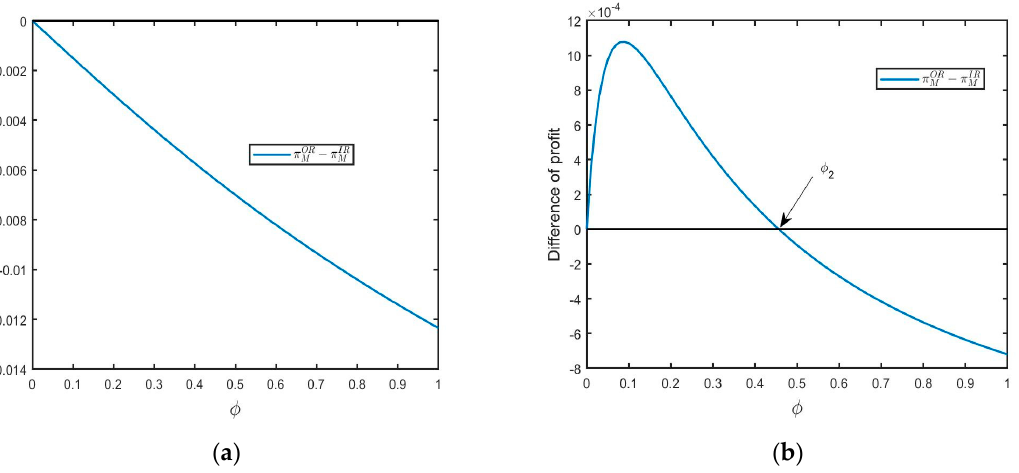
Figure 4. The impact of φ on profit difference: ( a ) µ 2 < σ 2 ( µ = 0.1, σ = 0.2, δ = 0.5 ) and ( b ) µ 2 > σ 2 and δ > δ 1 ( µ = 0.5, σ = 0.2, δ = 0.9 )